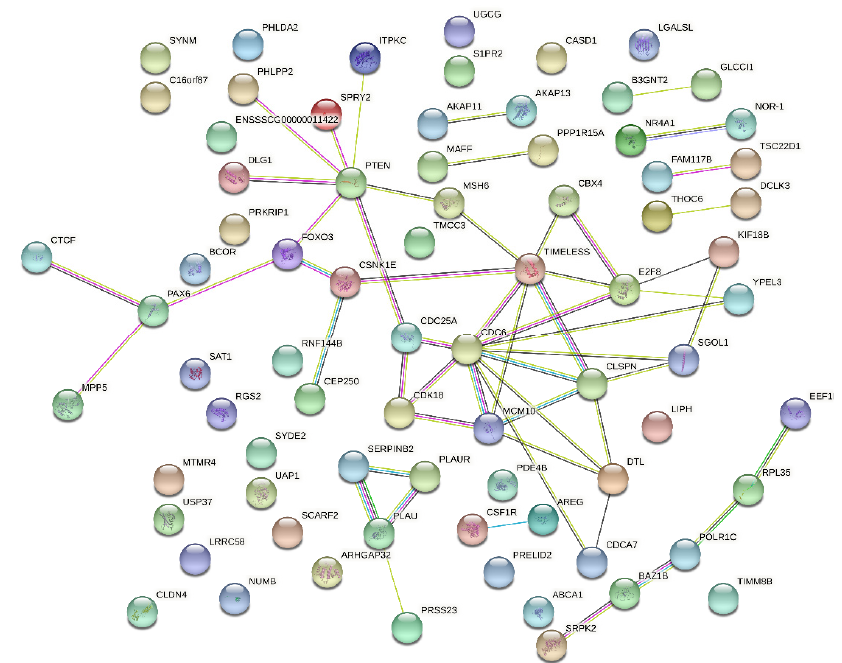
Figure 10. PPI analysis of the DEGs overlapping between the two DEG groups. 2.7. Validation of RNA-seq Data by qRT-PCR Ten genes were selected for validation of RNA-seq, and the results of qRT-PCR were consistent with those of transcriptomics (Figure 11).